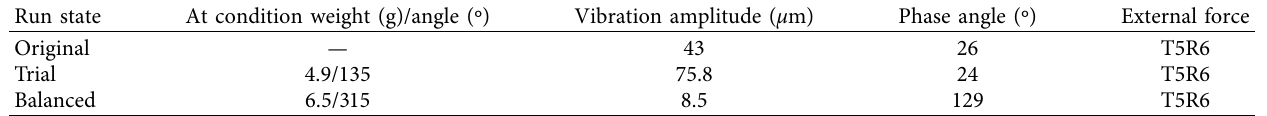
Table 10: Rotor balancing results using convention ICM with external